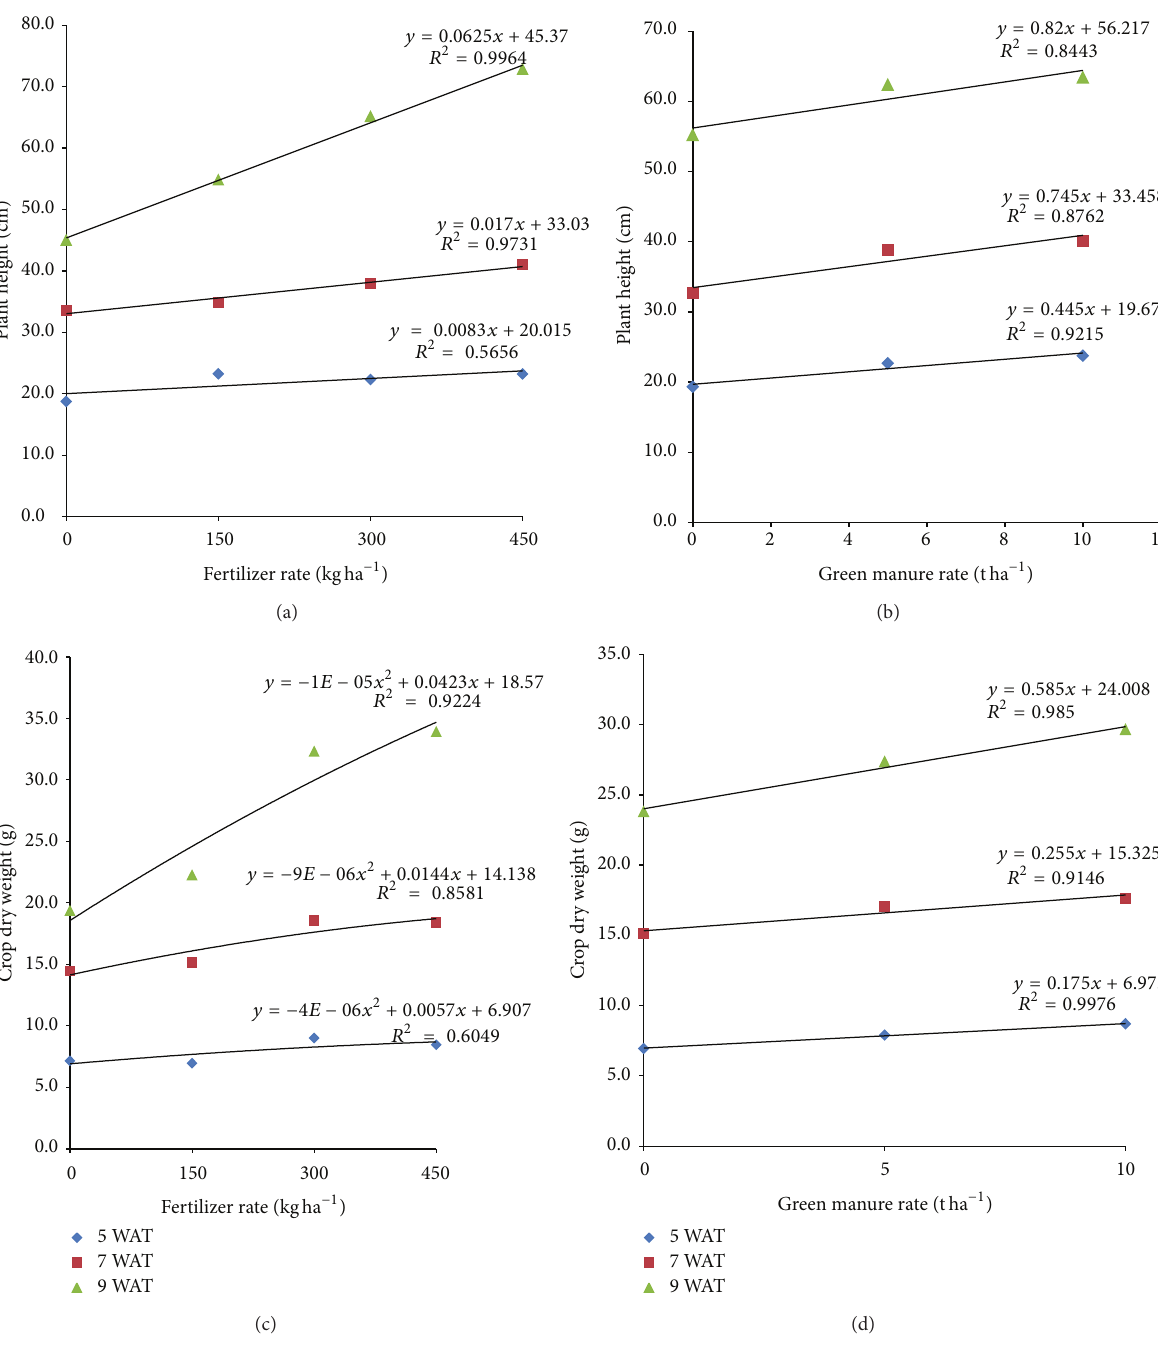
Similarly, green manure application increases plant height and crop dry weight is presented in Figures 1(b) and 1(c). The trends showed that applied green manure was linear, plant height followed the regression at 5, 7, and 9 WAT with determination of 𝑅 2 = 0.921, 0.876, and 0.844, respectively. Also crop dry weights at 5 WAT ( 𝑅 2 = 0.997), 7 WAT ( 𝑅 2 = 0.914), and 9 WAT ( 𝑅 2 = 0.985) were